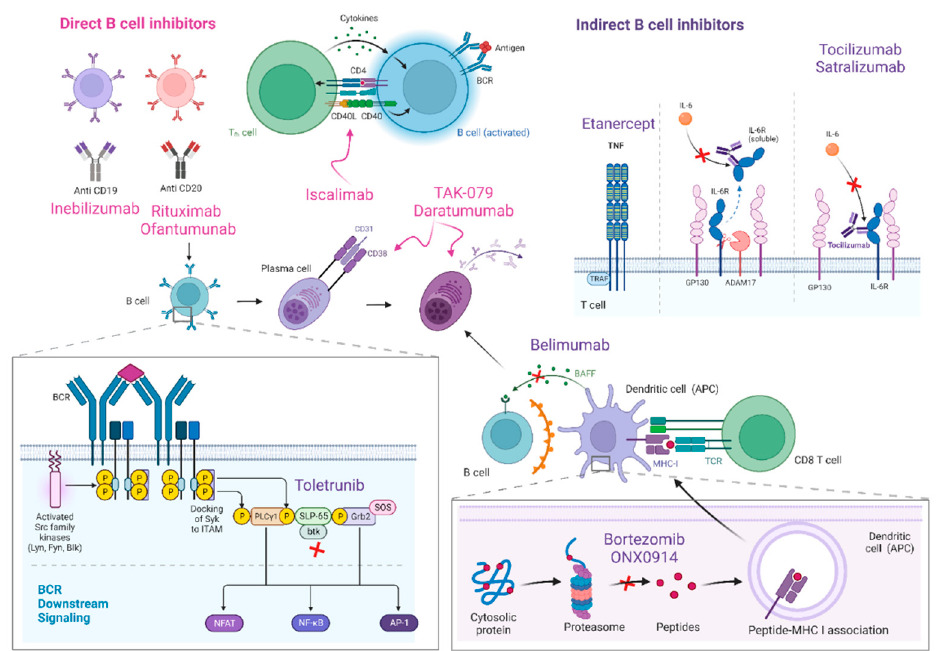
Figure 1. B-cell inhibitors and their main mechanisms of action are represented in this figure. Direct B cell inhibitors include monoclonal antibodies against CD19 (inebilizumab) and CD20 (rituximab and ofantumumab) B cell surface proteins, as well as iscalimab, a monoclonal anti-body against CD145-CD40. Drugs targeting plasma cells comprise proteasome inhibitors (borte-zomib and ONX0914) and anti-CD38 medications (mezagitamab or TAK-079 and daratumumab). Indirect B cell inhibitors are drugs designed to block IL-6 (tocilizumab and satralizumab), TNF (etanercept), BAFF (belimumab) or BTK (toletrunib).